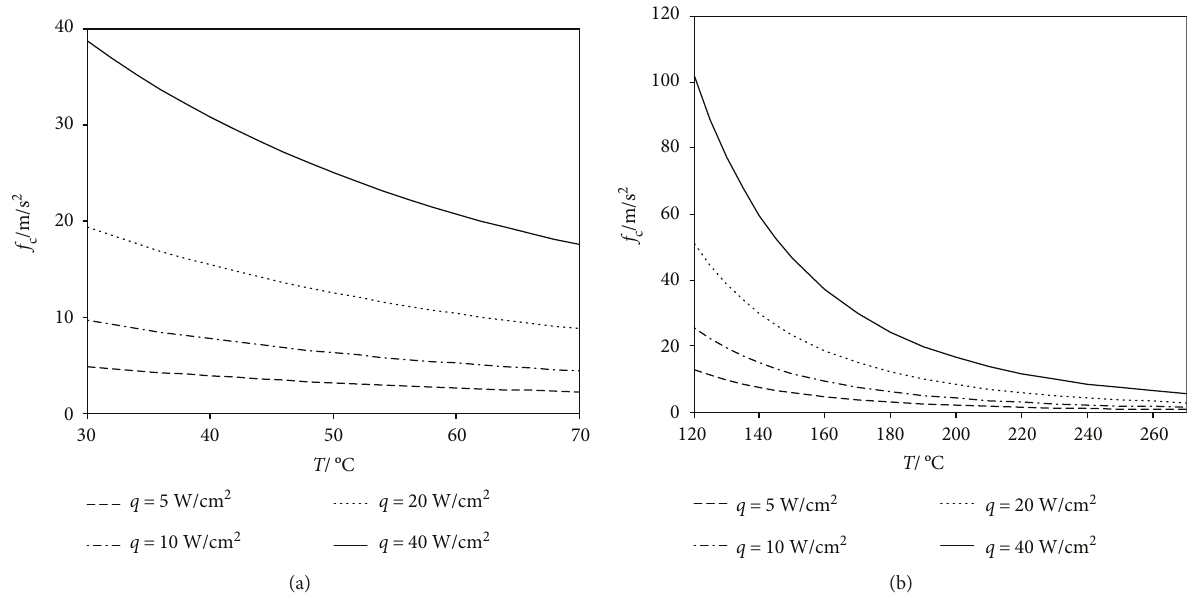
Figure 7: The maximum Coriolis force at di ff erent working conditions for di ff erent working fl uids. (a) For working fl uid R134a. (b) For working fl uid